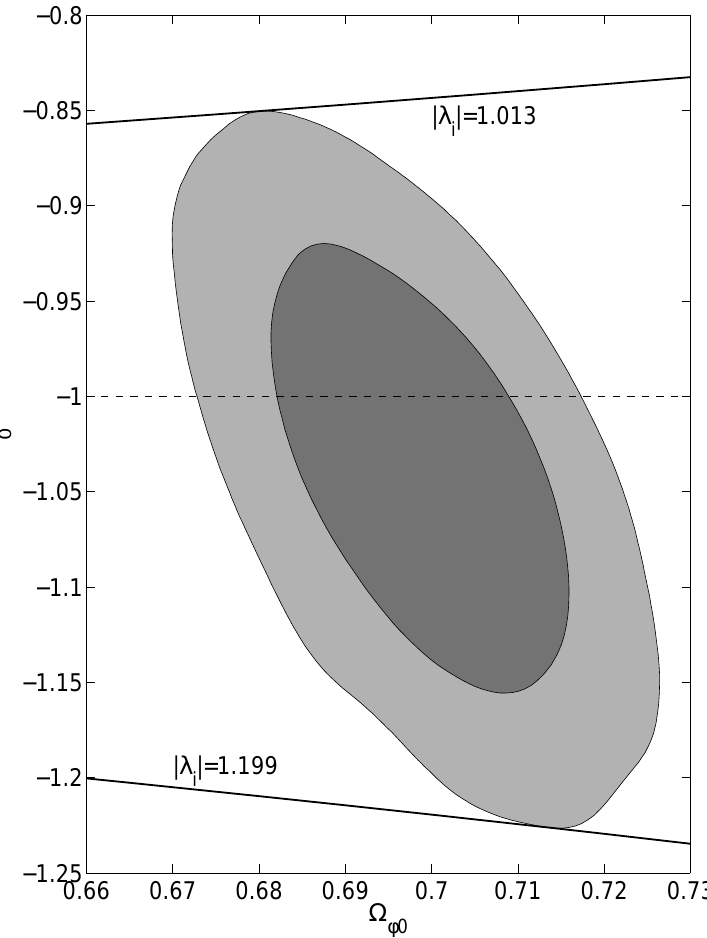
Figure 2. The marginalized 68% and 95% confidence contours of w φ 0 and Ω φ 0 from observational data. The solid lines denote the analytical relation